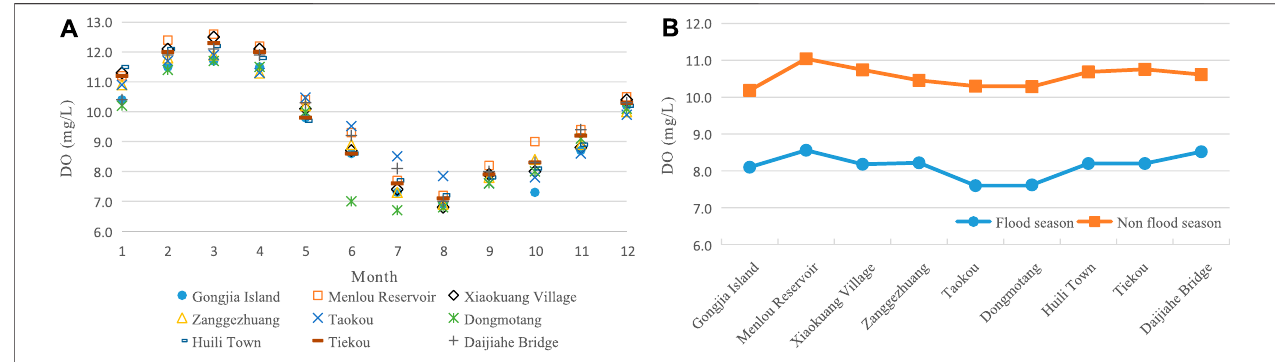
FIGURE4| DOconcentrationsintheDangujiaRiverinthe2008assessmentyear: (A) monthlyDOconcentrationsand (B) DOconcentrationsinthe fl oodandnon- fl ood seasons.